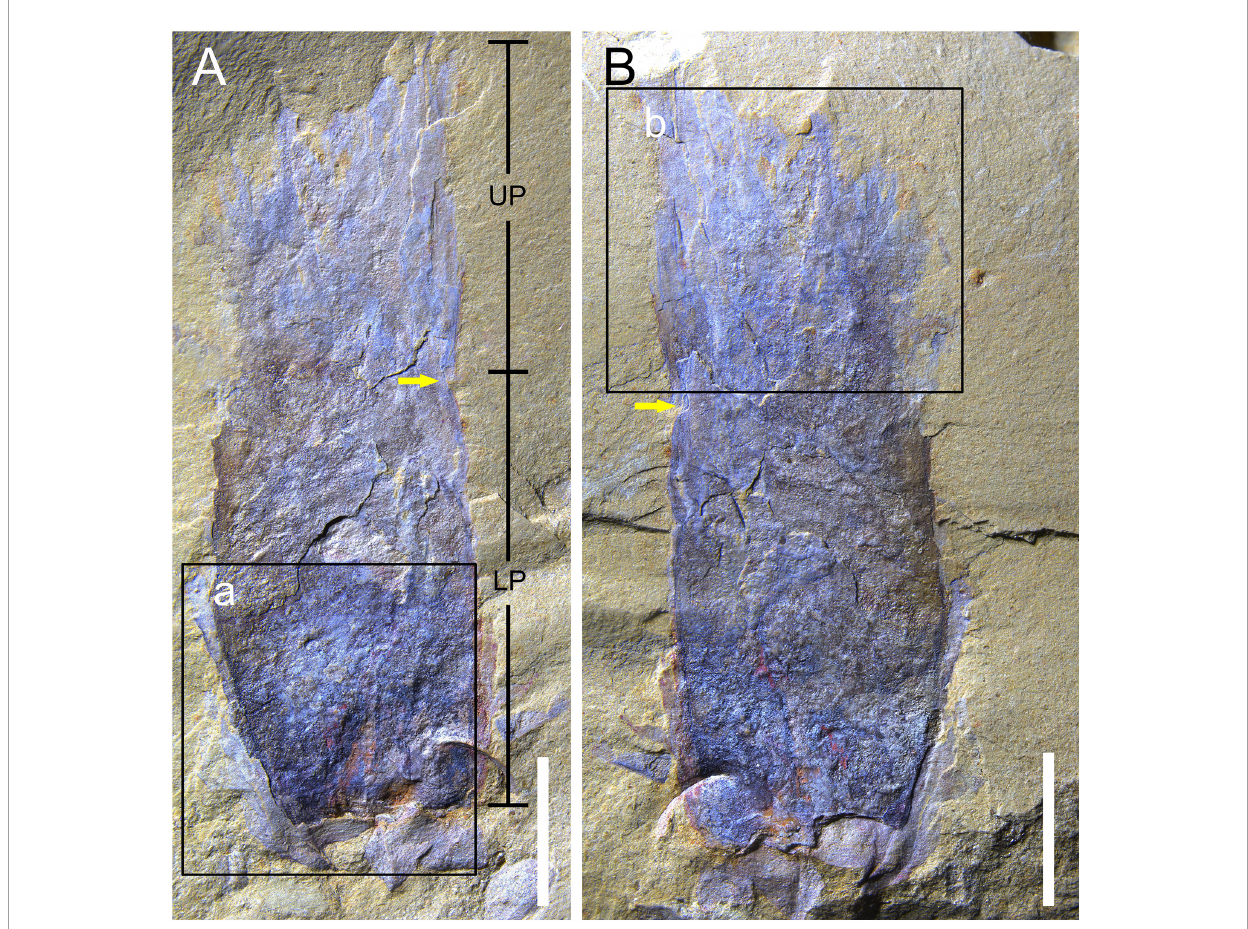
FIGURE1 The unnamed cnidarian-like metazoan (RCP-ZJ-0002). (A) Part; yellow arrow indicates the weak constriction between the upper portion and the lower portion of the body; (B) counterpart; yellow arrow indicates the weak constriction between the upper portion and the lower portion of the body. The scale bars are 5 mm. UP, upper portion; LP, lower portion.